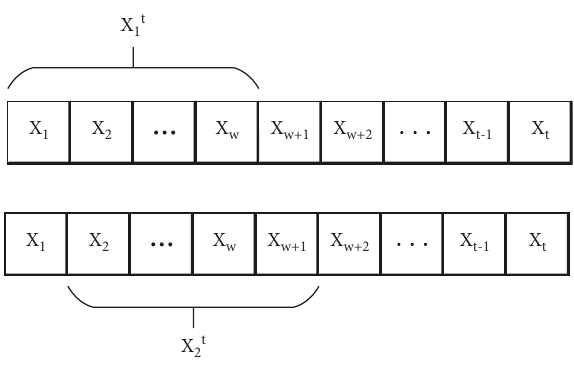
Figure 3: Sliding window algorithm.